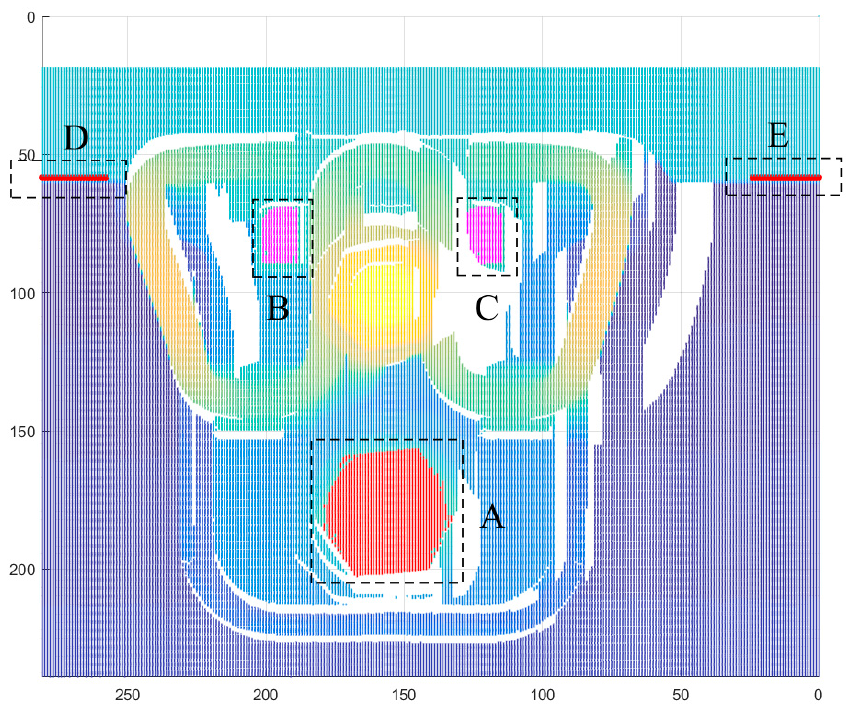
Figure 12. Extracted point clouds of the key components for a WJ-7 fastener.